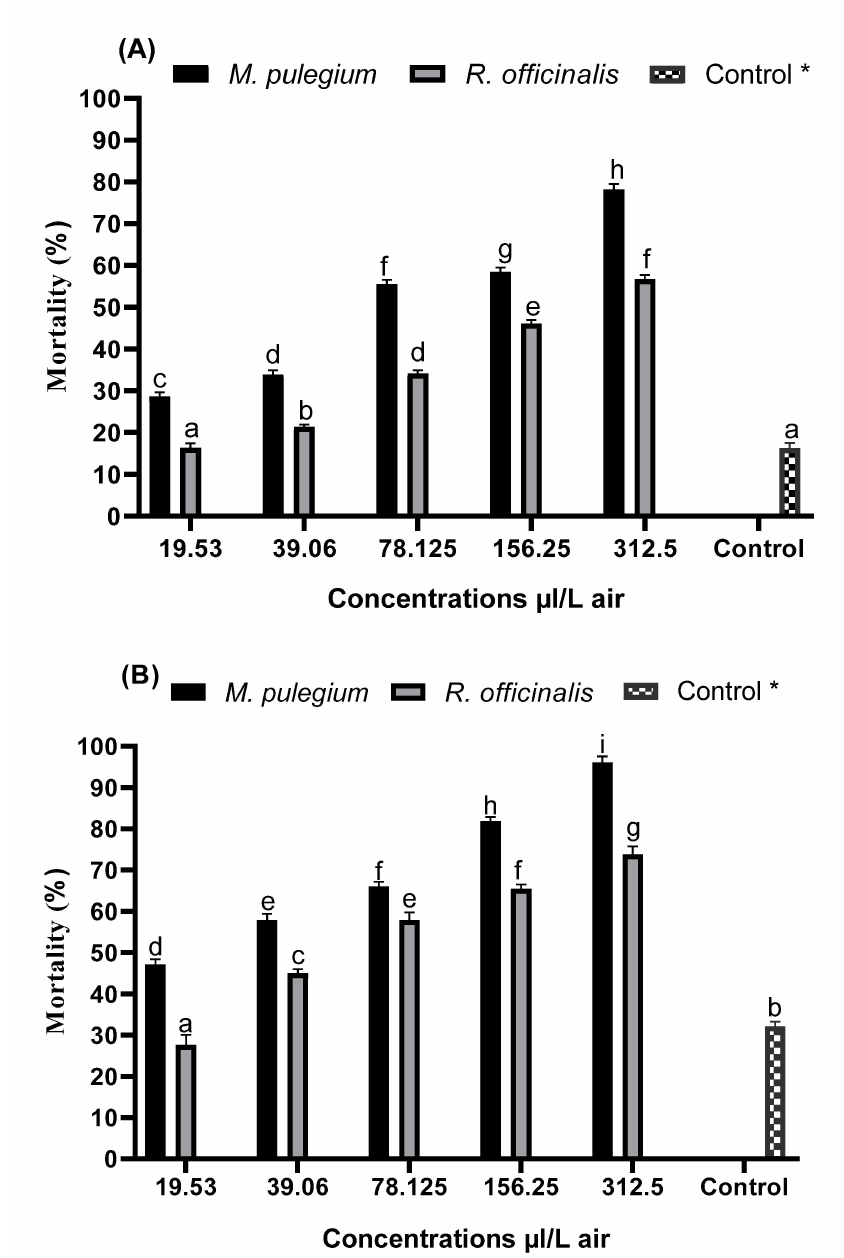
Figure 1. Evaluation of M. pulegium and R. officinalis EOs toxicity on C. pipiens adults according to different concentrations: ( A ): After 24 h; ( B ): After 48 h. (*): Positive control (Deltamethrin 0.05%). Means followed by the same letter are not significantly different at p -value